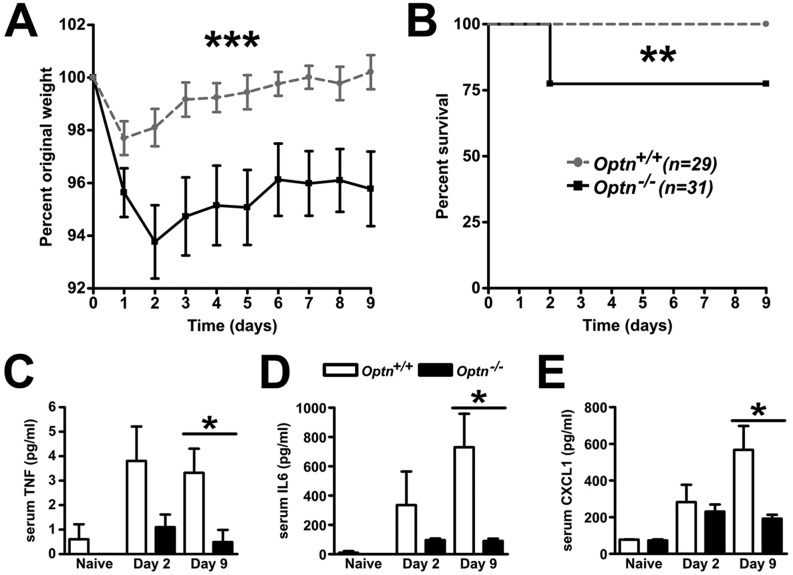
Citrobacter colitis results in greater mortality and lower levels of serum pro-inflammatory cytokines in OPTN-deficient mice. (A,B) Optn+/+ (grey) and Optn−/− (black) mice were gavaged with live Citrobacter rodentium and followed for 9 days to assess (A) weight loss and (B) mortality (n=29-31 mice/genotype over 5 experiments). (C) Serum TNF, (D) IL6 and (E) CXCL1 were measured in naïve mice, day 2 and day 9 after Citrobacter inoculation, in tail bleed and cardiac puncture serum (n=5 mice/group). Results shown are mean±s.e.m. (*P<0.05, **P<0.01 and ***P<0.001; two-tailed, unpaired t-test and logrank test).